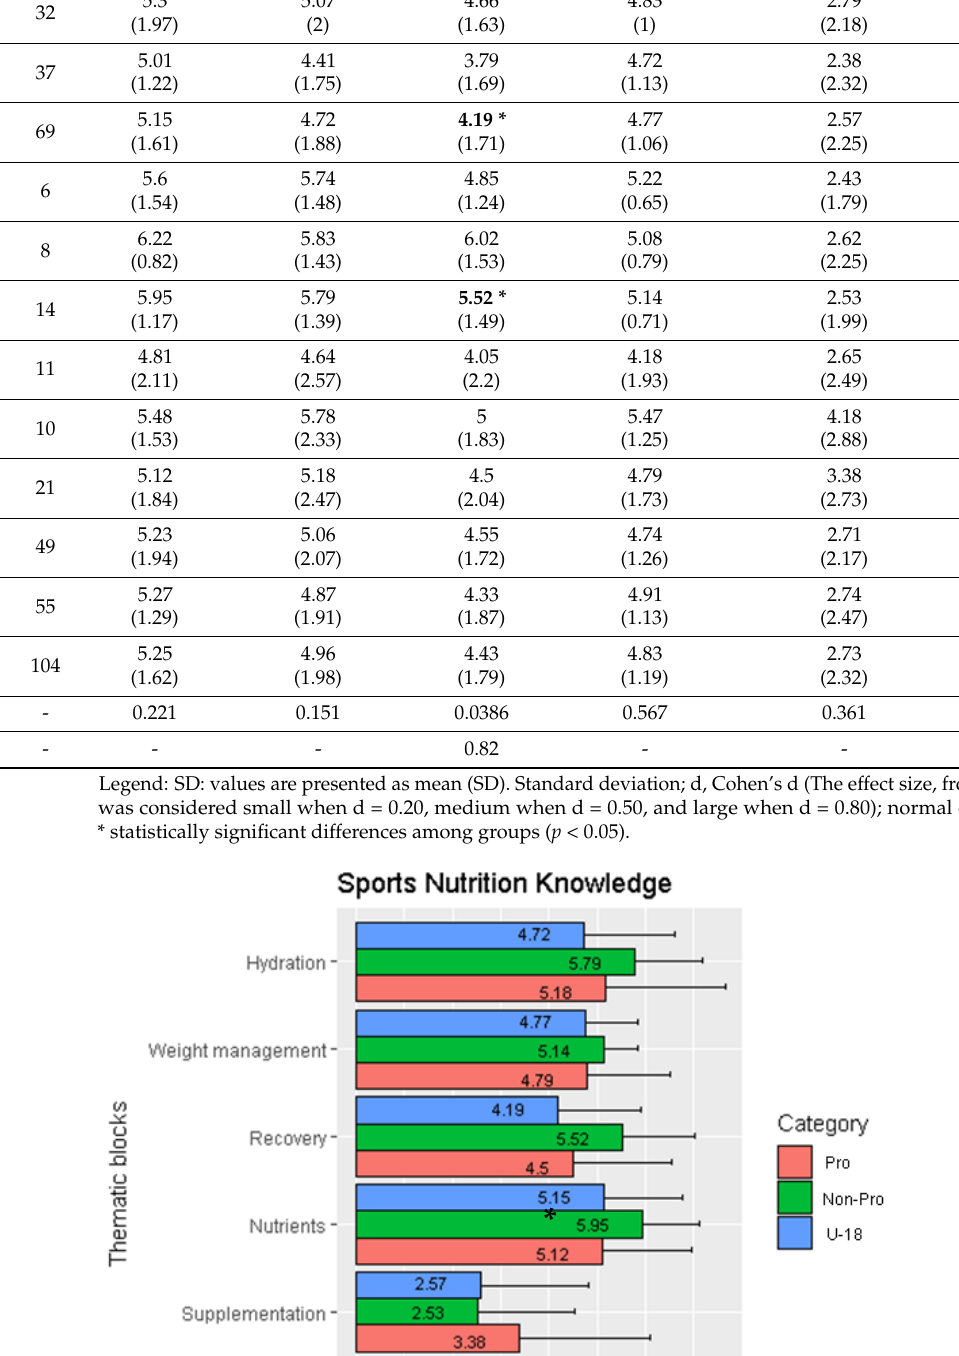
Figure 2. Sports nutrition knowledge (total).